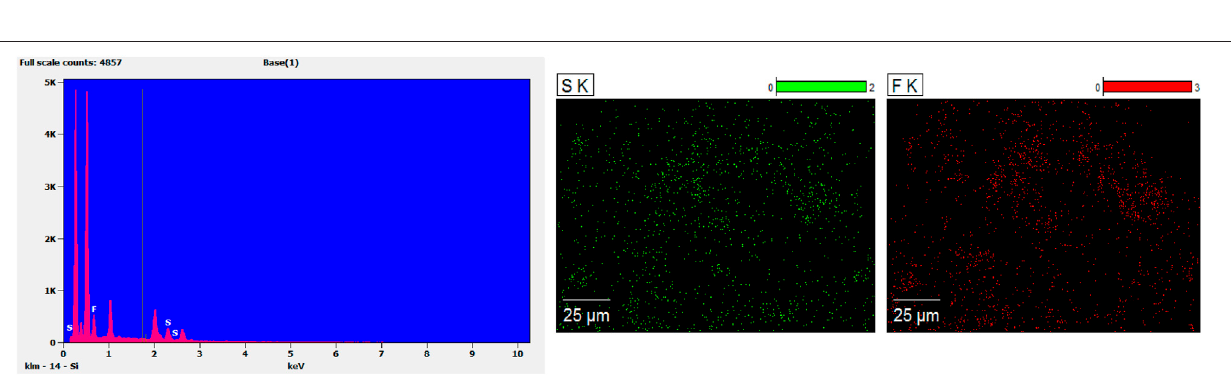
FIGURE 4 | The EDS results showed the F (red) and S (green) were evenly distributed in the hydrogel, and indirectly indicated that the hydrogel had successfully encapsulated celecoxib.